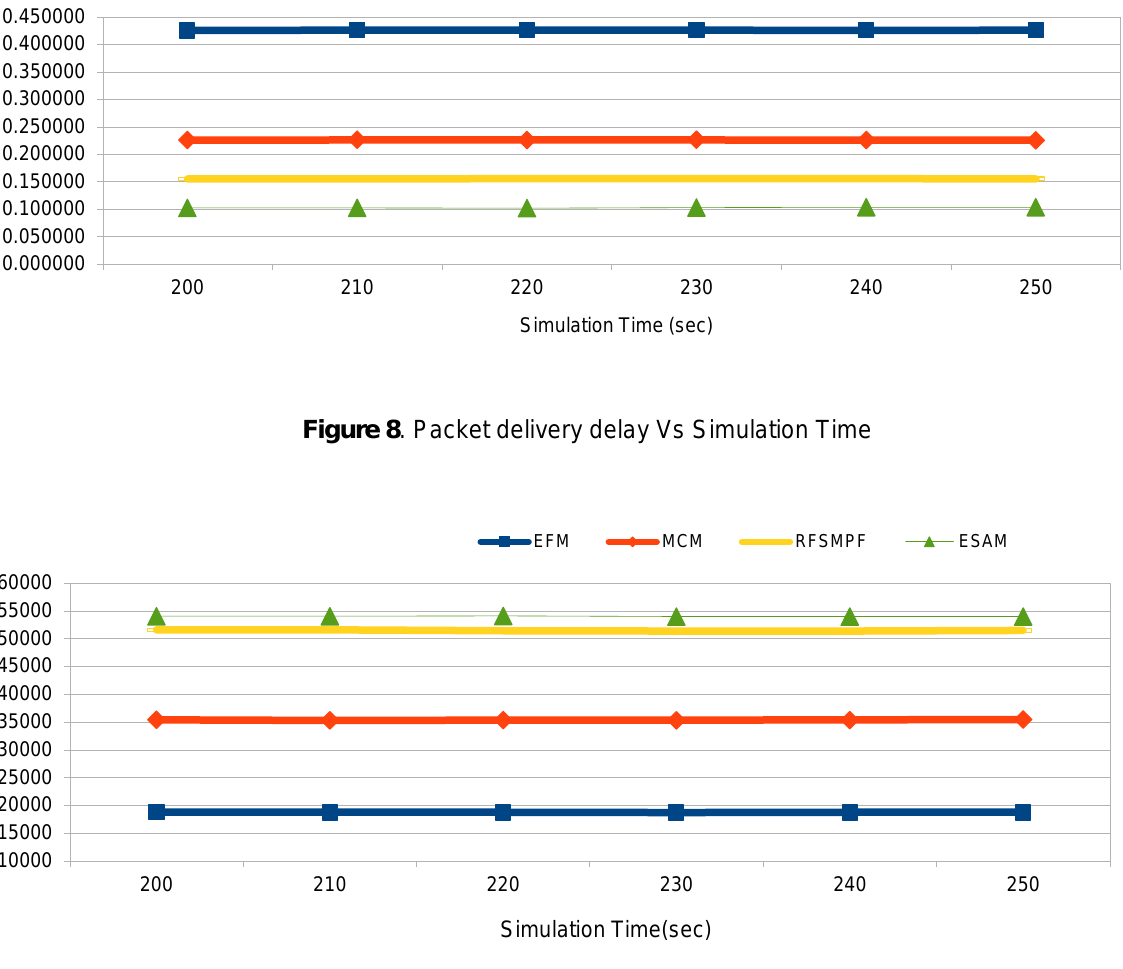
Figure 9. Good put Vs Simulation